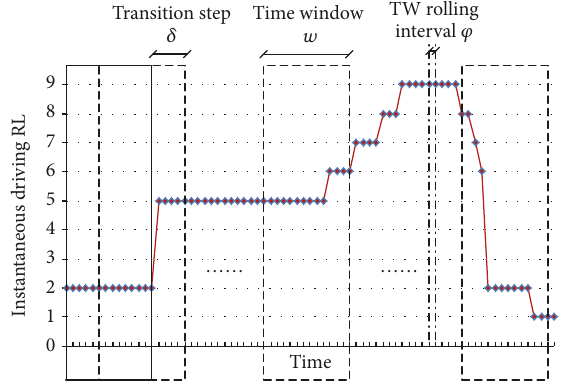
Figure 3: Diagram of rolling time